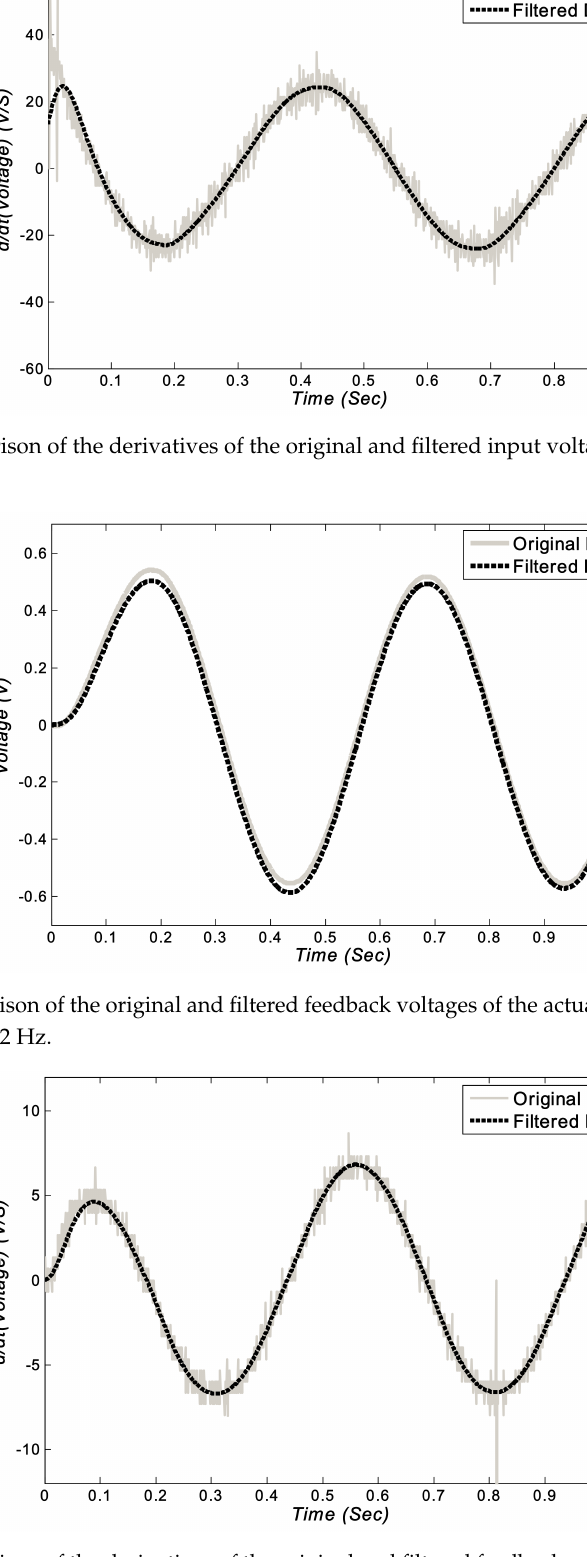
Figure 19. Comparison of the derivatives of the original and filtered feedback voltages of the actuator’s LVDT for Amp = 20 mm and Freq = 2